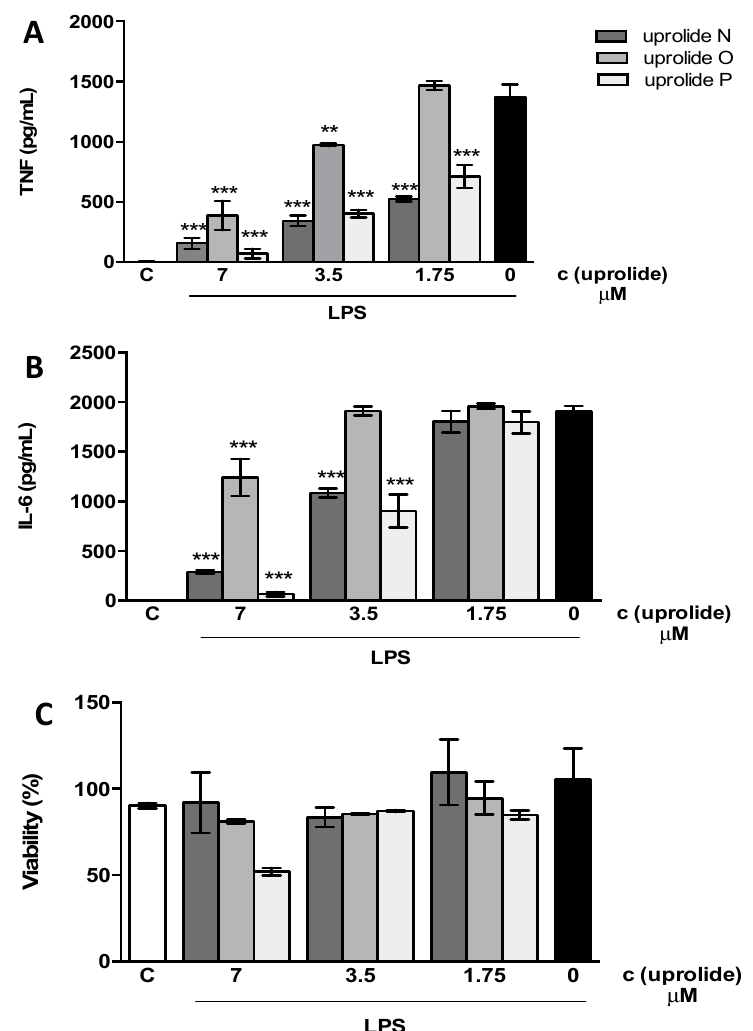
Figure 5. Uprolides compounds inhibit the production of TNF ( A ) and IL-6 ( B ) induced by LPS in macrophages. Peritoneal macrophages from C57B1/6 mice were treated with different concentrations of compounds 1 , 2 or 3 (uprolides N, O or P) 1 h before stimulation with 100 μ g/mL of LPS. The supernatants were harvested after 6 h, and cytokine concentrations were determined by ELISA. Results are represented as Mean ± S.E.M. from two independent experiments performed in duplicate. **, p < 0.01, ***, p < 0.001 relative to the LPS stimulus alone. ( C ) The cell viability was assessed using a MTT assay after collecting the supernatant. Results are represented as Mean ± S.E.M. from stimuli performed in duplicate and are representative of two different experiments. C represents the control plus 0.5% of DMSO without the stimulus. Table 2. Anti-inflammatory activity of the new uprolides N-P ( 1 – 3 ) and dolabellane ( 4 ).